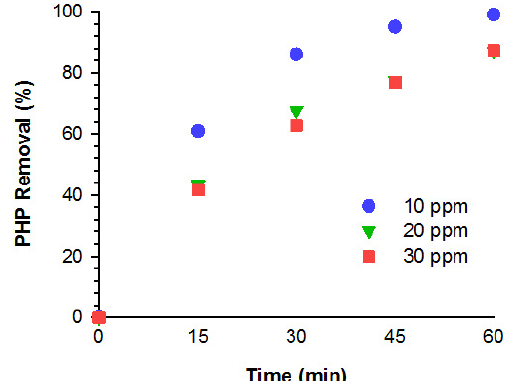
Fig. 10. Effect of the pollutant concentration on the PHP removal efficiency. Reaction conditions: pH = 7, 0.1 A, and [catalyst] = 0.2 gL -1 .